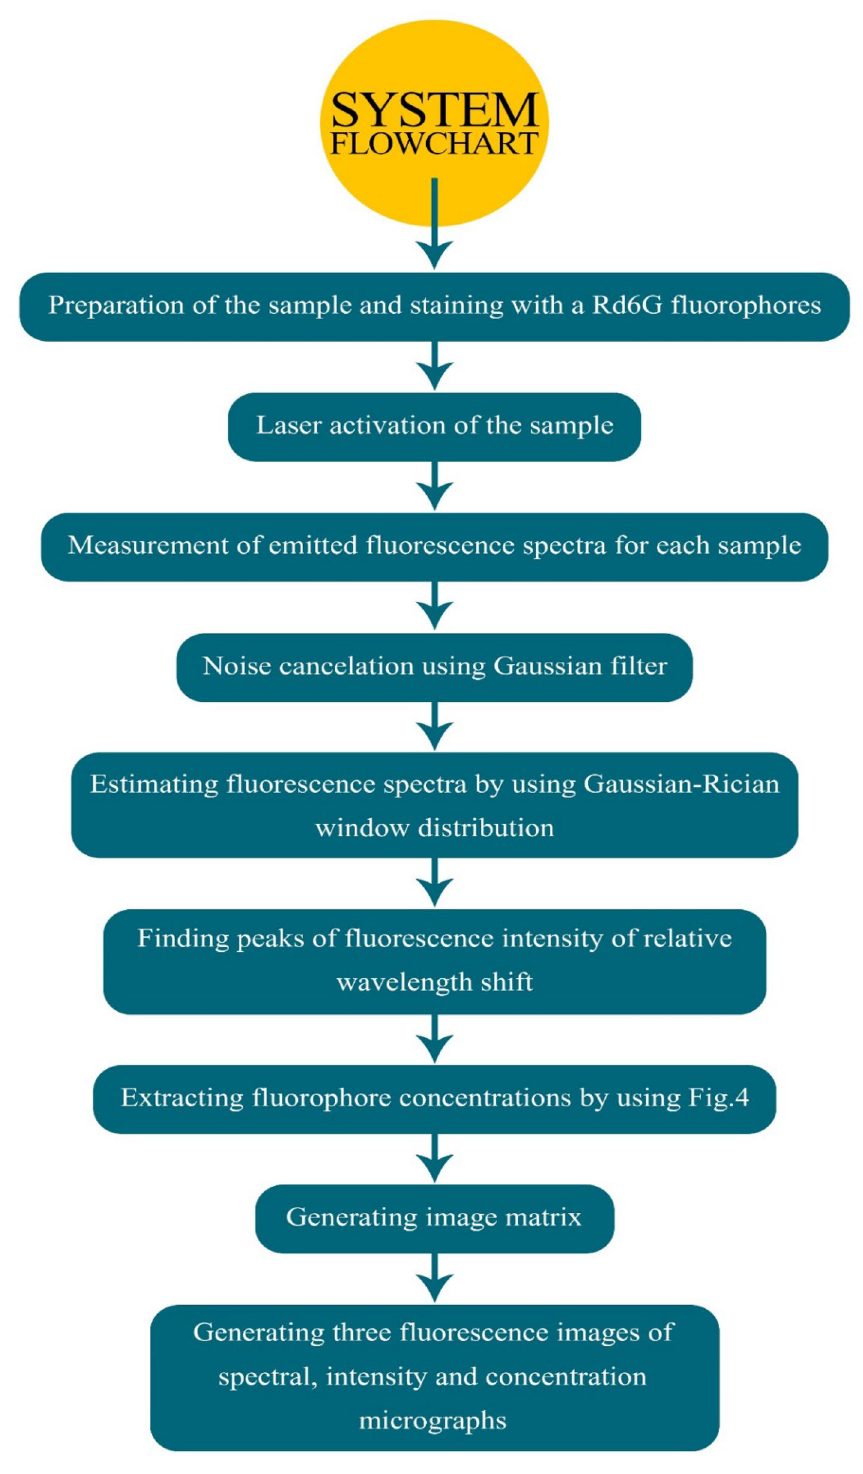
Figure 7. The stage-by-stage flowchart of the signal processing including tissue preparation, laser excitation, fluorescence spectra acquisition, denoising, data smoothing, and micrographs generation based on Figs. 1c and 4